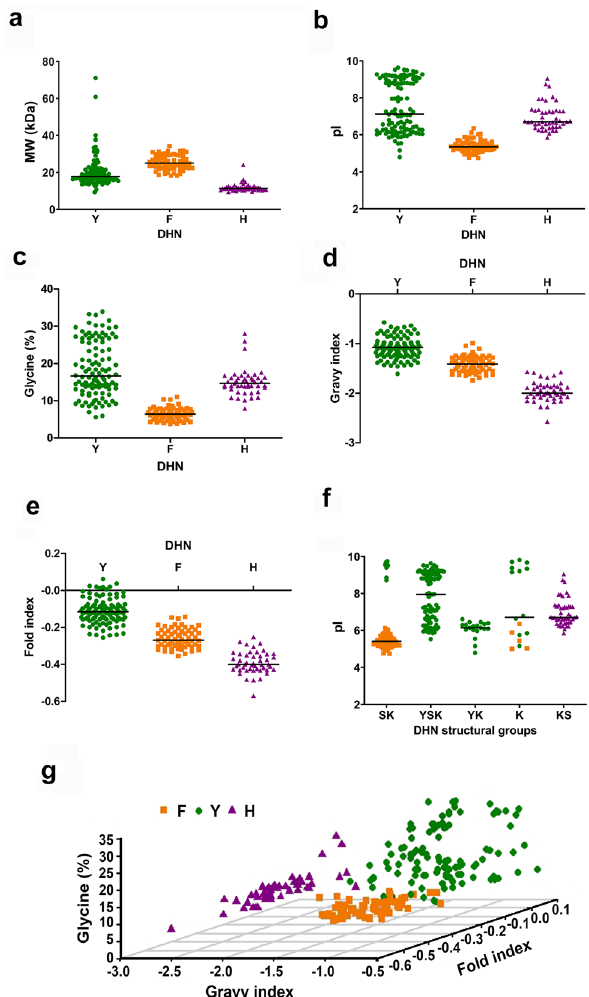
Figure 7. Distribution of biochemical and biophysical properties of angiosperm DHNs. Scatter plots show the distribution of molecular weight ( a ), isoelectric point ( b and f ), glycine content ( c ), GRAVY index ( d ), Fold Index ( e ) or glycine content, GRAVY and Fold index simultaneously ( g ) in orthologous or structural subgroups of DHNs. Members of the three orthologous groups of DHNs are colour-coded: Y- (green), F- (orange) and H-DHNs